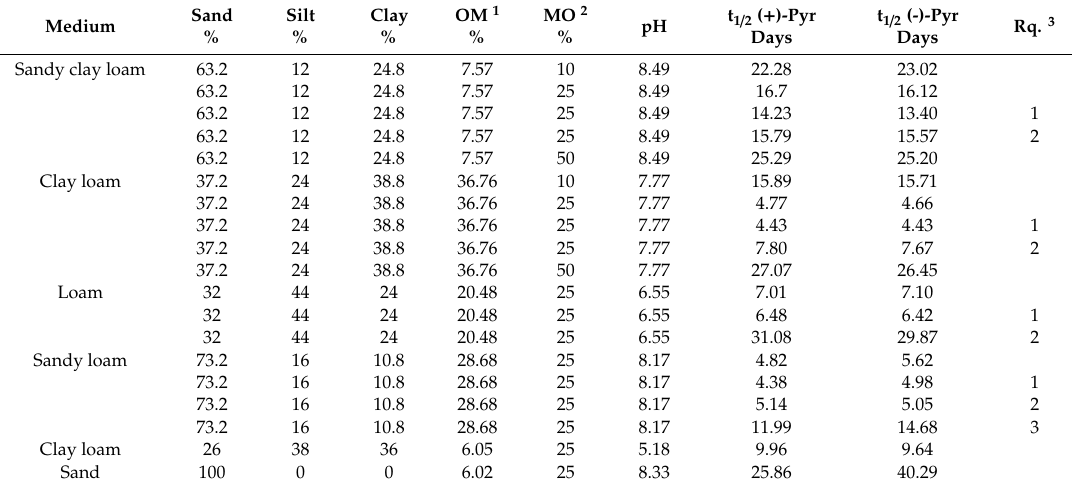
Table 1. Half-life values (t 1 / 2 ) of pyriproxyfen enantiomers in di ff erent types of soils and sand under aerobic conditions and with various experimental conditions (adapted from [27]).